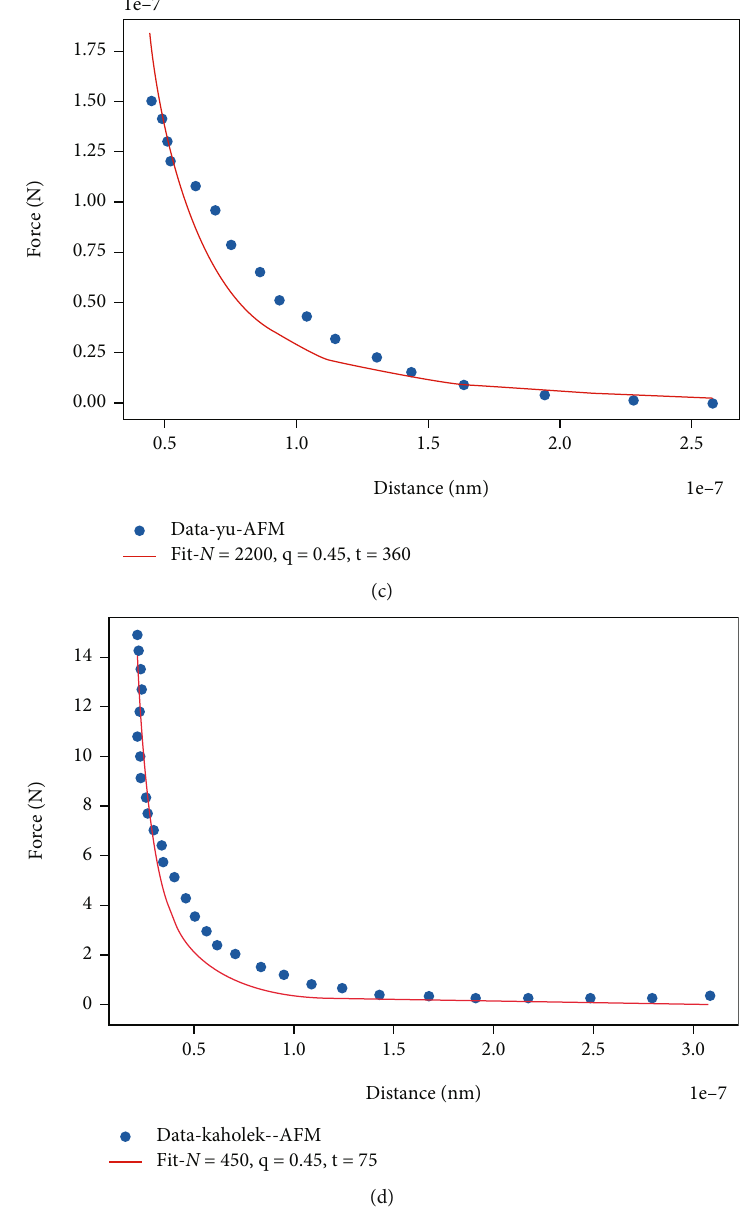
Figure 5: A plot of force versus distance for a PNIPAM polymer brush-coated mica and bare mica surface in water. Dots are experimental data digitized from ref [29, 34 – 37], and the solid line is a curve fi tted to the data points (Equation